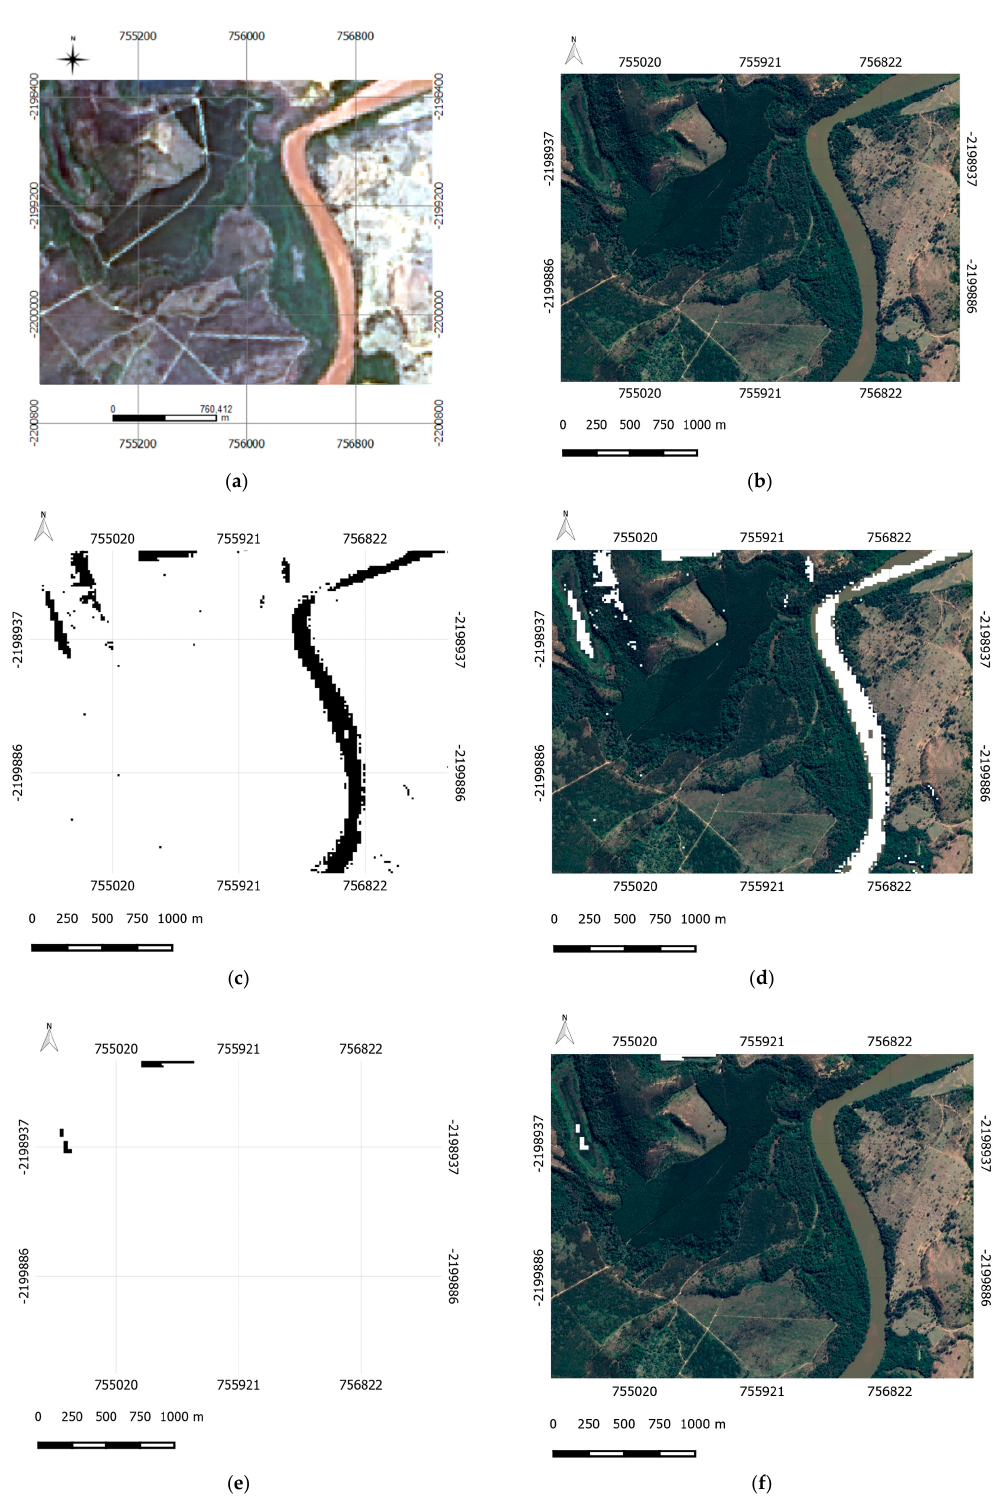
Figure 9. An example of the application of our strategy on an image tile taken from the image of the Doce River acquired by Landsat 8 in 2015: ( a ) enhanced image, in which there are two water bodies (the thick winding river and a narrow lake on the top); ( b ) the real image; ( c ) contextual classifier (boost) output; ( d ) result overlay of ( c ) (white) on the real image; ( e ) non-contextual classifier (decision tree) output; ( f ) result overlay of ( e ) (white) on the real image. In ( c , e ), black and white represent pixels classified as water and no-water, respectively.